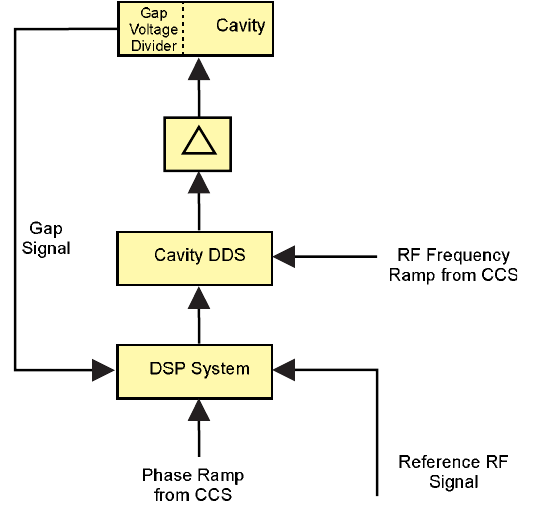
FIG. 2. Phase synchronization of the cavity gap voltage with a reference rf